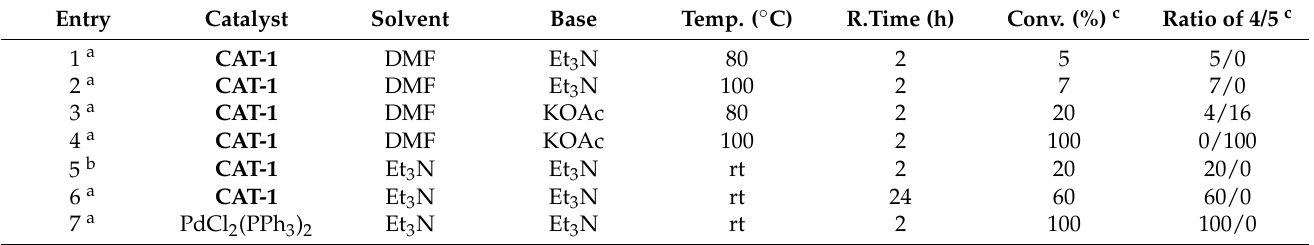
Table 1. Optimization of the Sonogashira coupling of iodobenzofuran 1 and